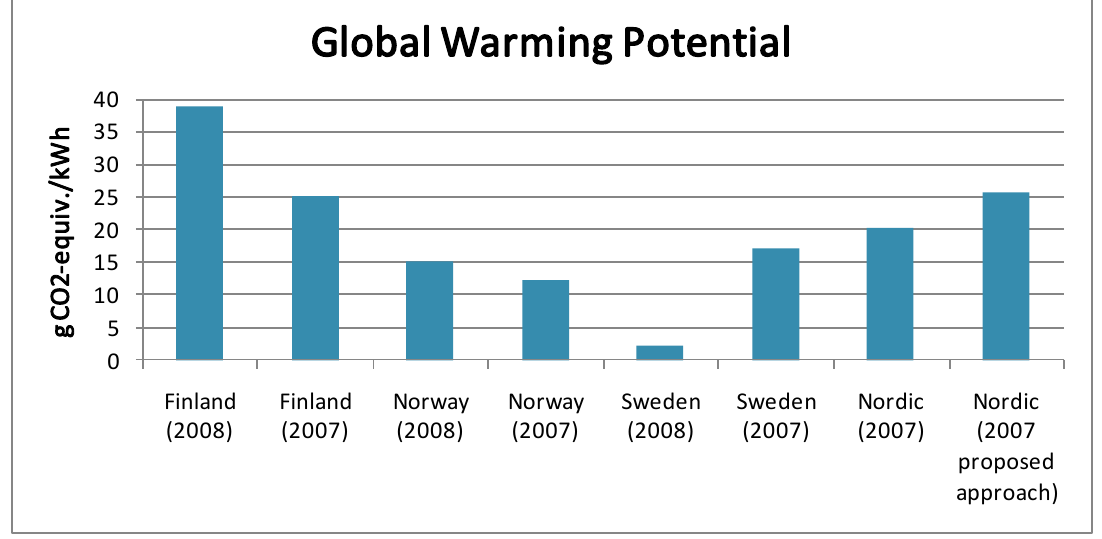
Figure 5. Calculated Global Warming Potential (GWP) per kWh electricity for different residual electricity mixes using the Life Cycle Assessment